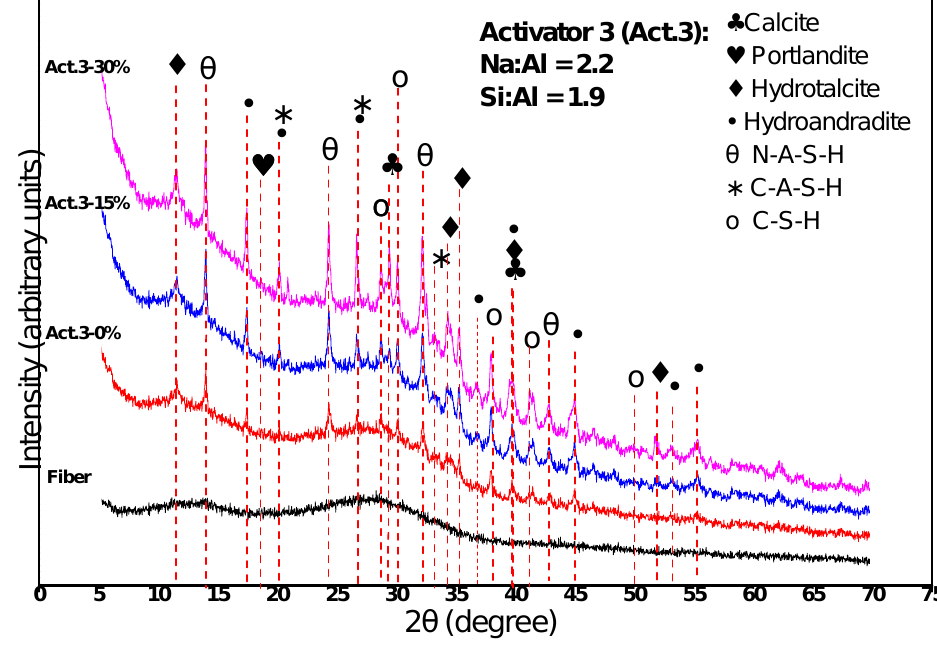
Figure 11. Diffractograms (XRD) of the combinations of alkali-activated cement with Act.3, with- out addition and with addition of OPC. The phases identified were: hydrotalcite, ((Mg 4 Al 2 )(OH) 12 (CO 3 )(H 2 O) 3 ) 0.5 : Pow- der Diffraction File (PDF) #00-014-0191; hydroandradite, Ca 3 Fe 2 (SiO 4 ) 1.15 (OH) 7.4 : (PDF) #01-075-0553; Y-type zeolite, Na 3 H 53 Al 56 Si 136 O 384 : (PDF) #00-038-0239; sodium alumina- silicate hydrate, N-A-S-H: (PDF) #00-041-0009; calcium alumina-silicate hydrate